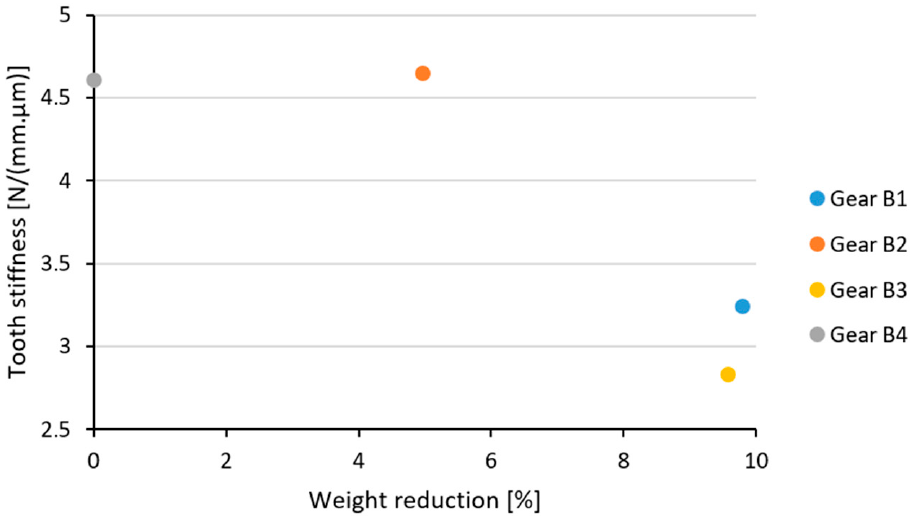
Figure 18. Influence of material loss on maximum gear stiffness for cast spur gears.